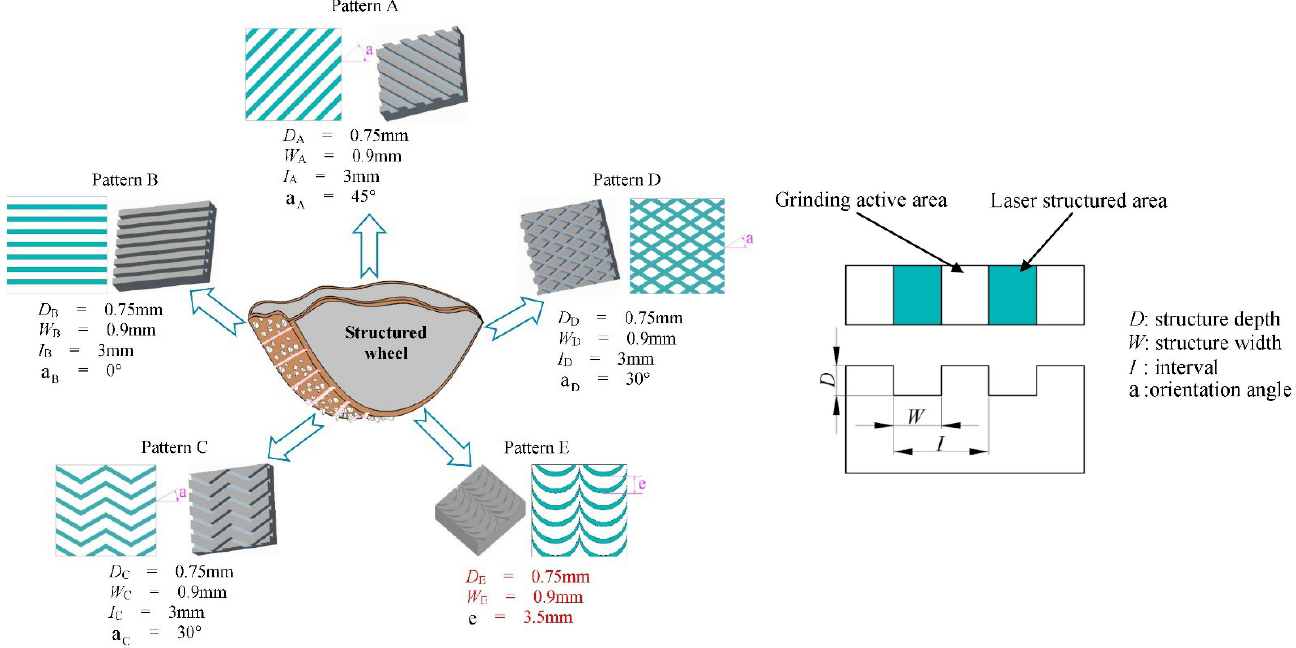
Figure 12. Different laser groove patterns discussed by Zhang et al. [87].